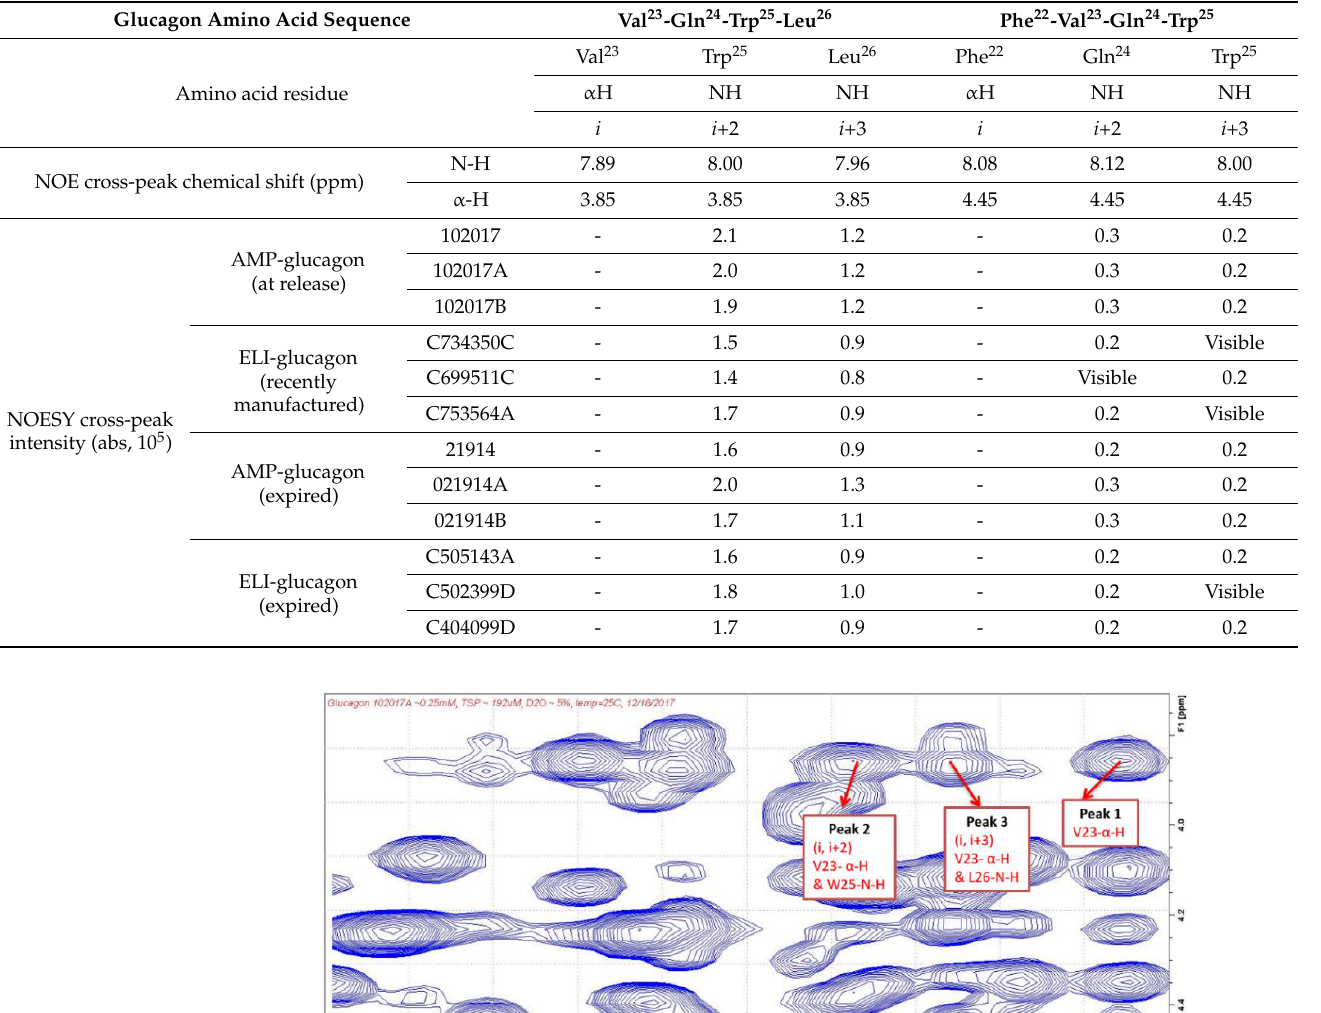
Table 3. NOESY Cross-Peak Intensity for AMP-Glucagon and ELI-Glucagon.